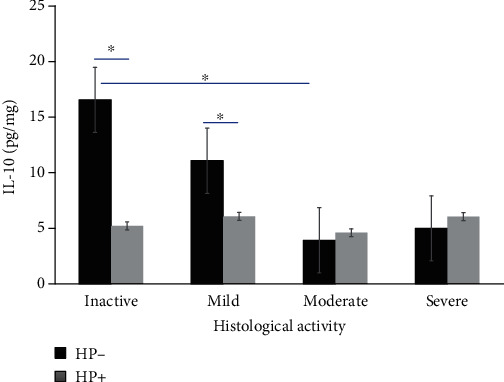
IL-10 levels in ulcerative colitis correlate with histological activity. IL-10 levels in serum from UC patients according to Riley Histological Activity subscore endoscopic activity; bars show means with standard error of the mean of IL-10, and differences among groups were assessed by the Mann–Whitney U test. ∗P value < 0.05.